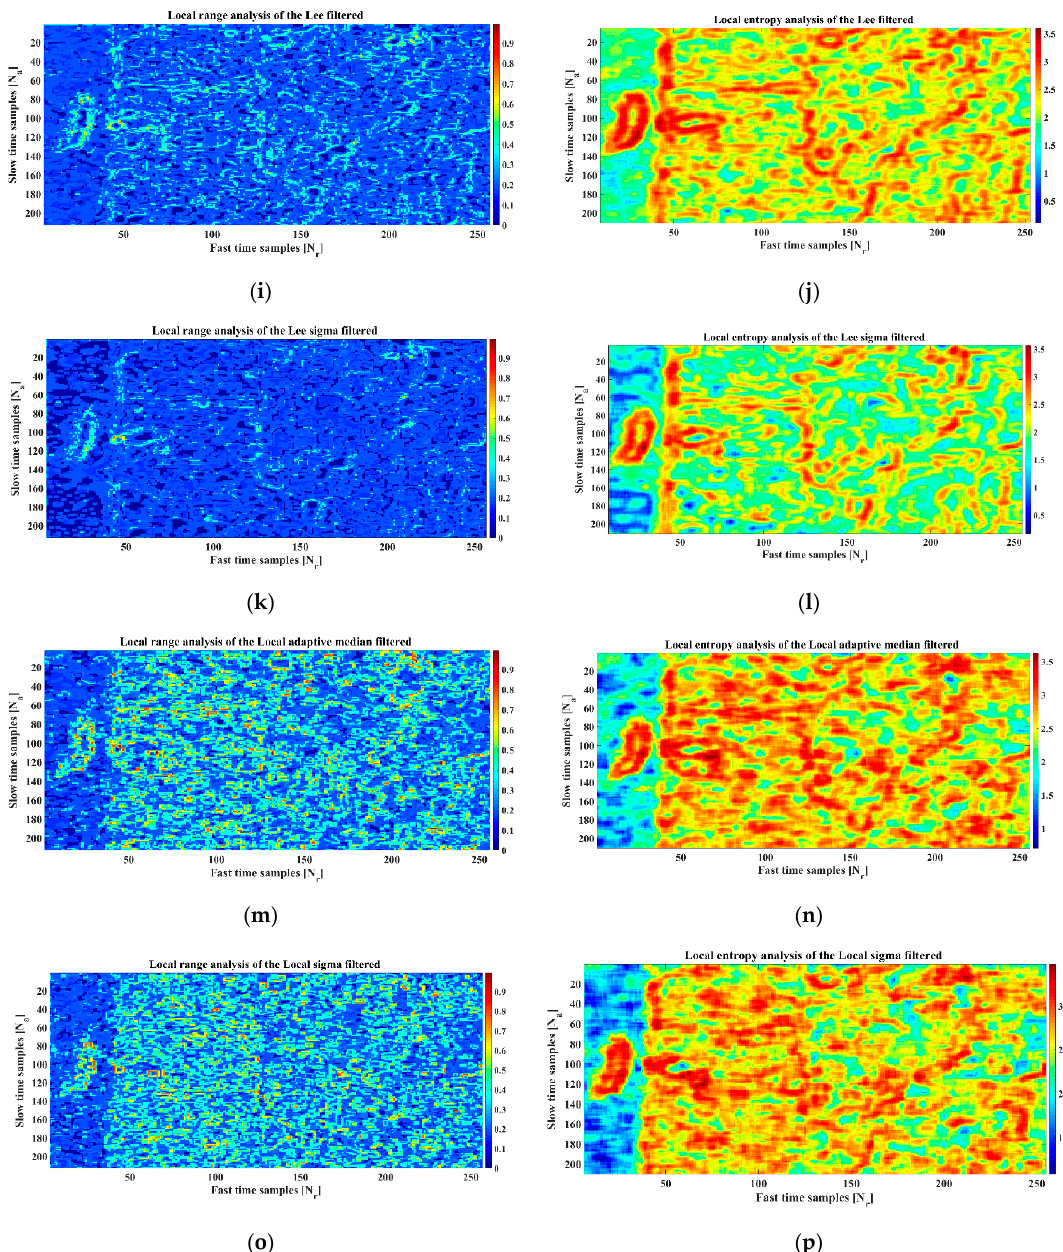
Figure 13. Texture content analysis based on local range and local entropy ( a ) reference SAR image; ( b ) reference SAR image; ( c ) Frost filtered; ( d ) Frost filtered; ( e ) Gamma filtered; ( f ) Gamma filtered; ( g ) Kuan filtered; ( h ) Kuan filtered; ( i ) Lee filtered; ( j ) Lee filtered; ( k ) Lee sigma filtered; ( l ) Lee sigma filtered; ( m ) Local adaptive median filtered; ( n ) Local adaptive median filtered; ( o ) Local sigma; ( p ) Local sigma.